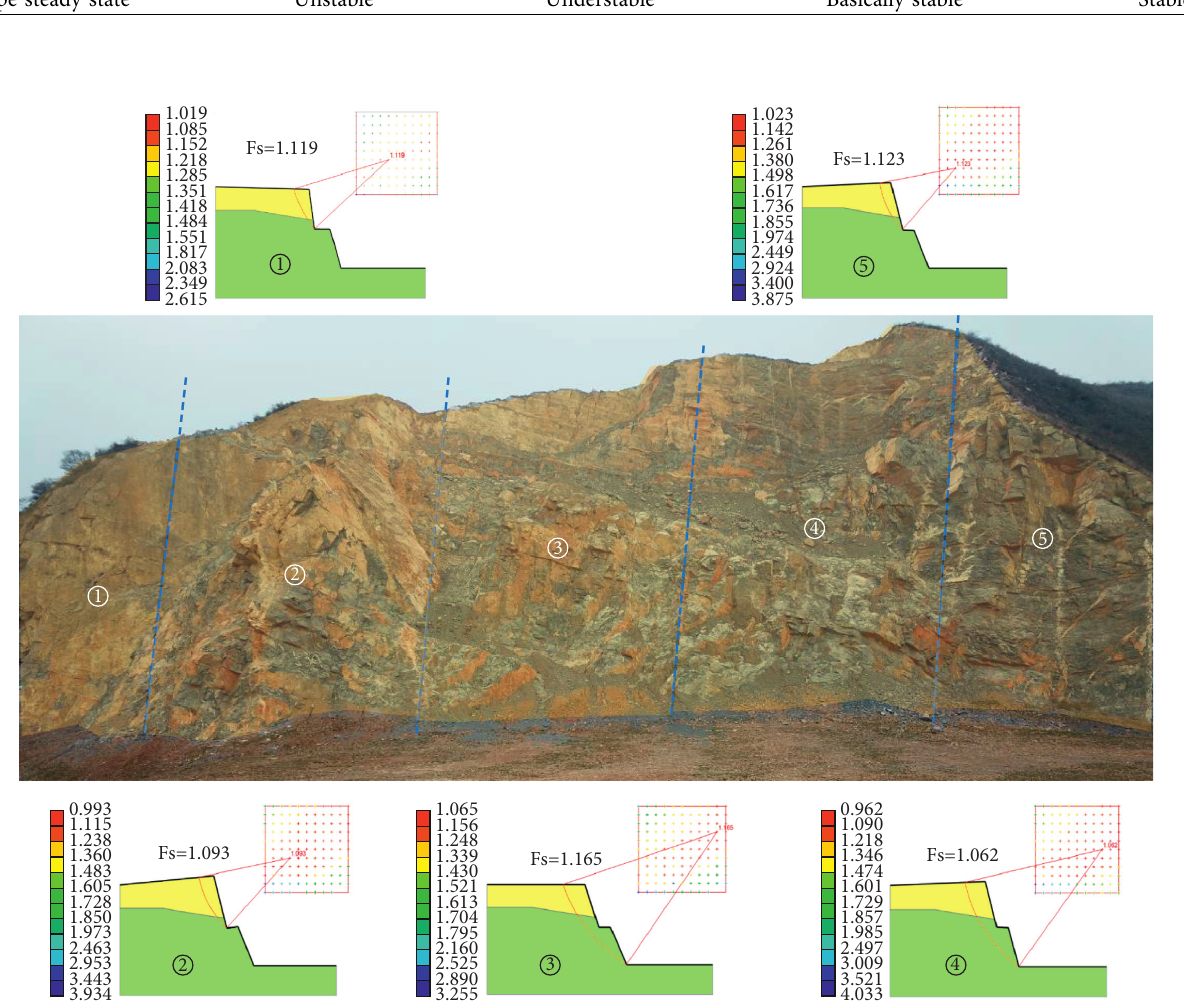
Figure 18: Safety factor of mine slope